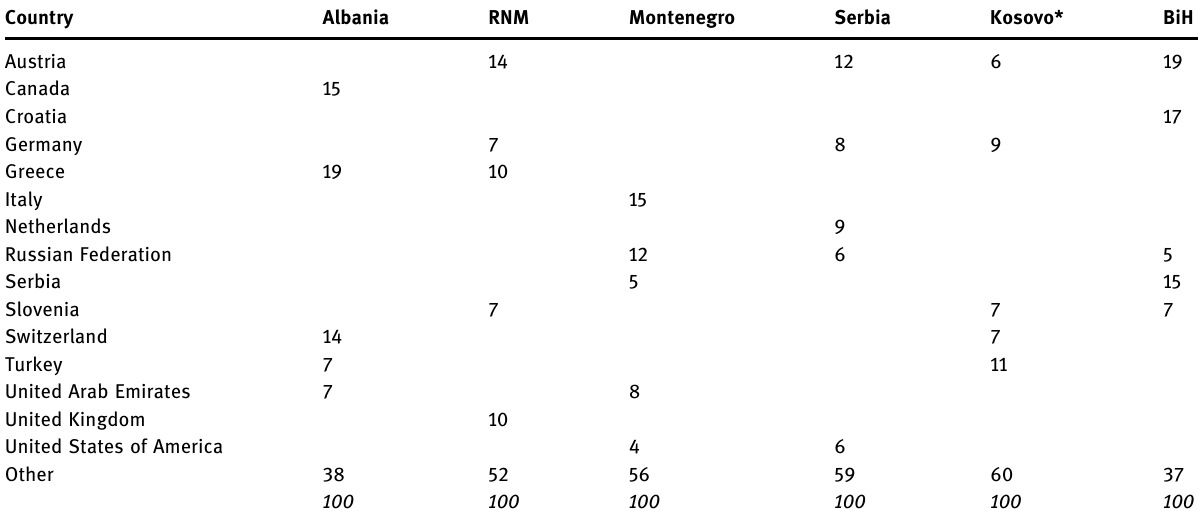
Country Albania RNM Montenegro